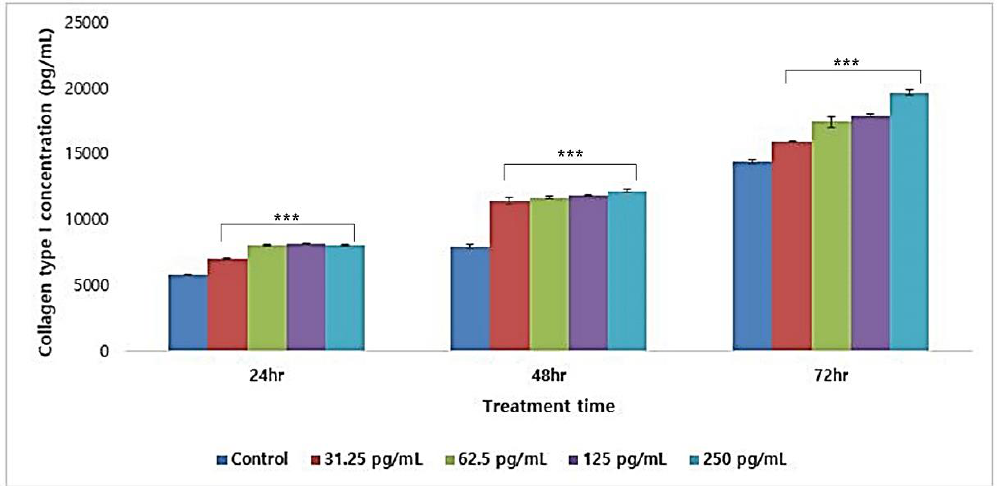
Figure 6. Synthesis of collagen type I using T65 crude product in 24, 48, and 72 h. Data are given as mean ± SEM. *** p < 0.05 compared to control in respective hours.